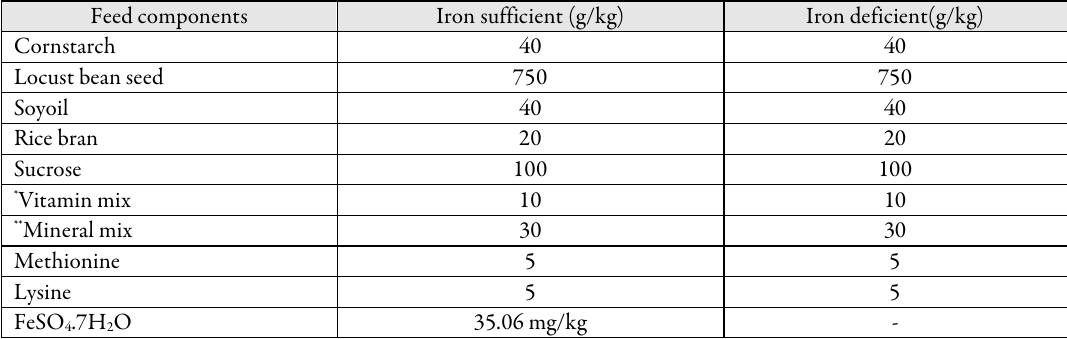
Table 1. Composition of formulated diet